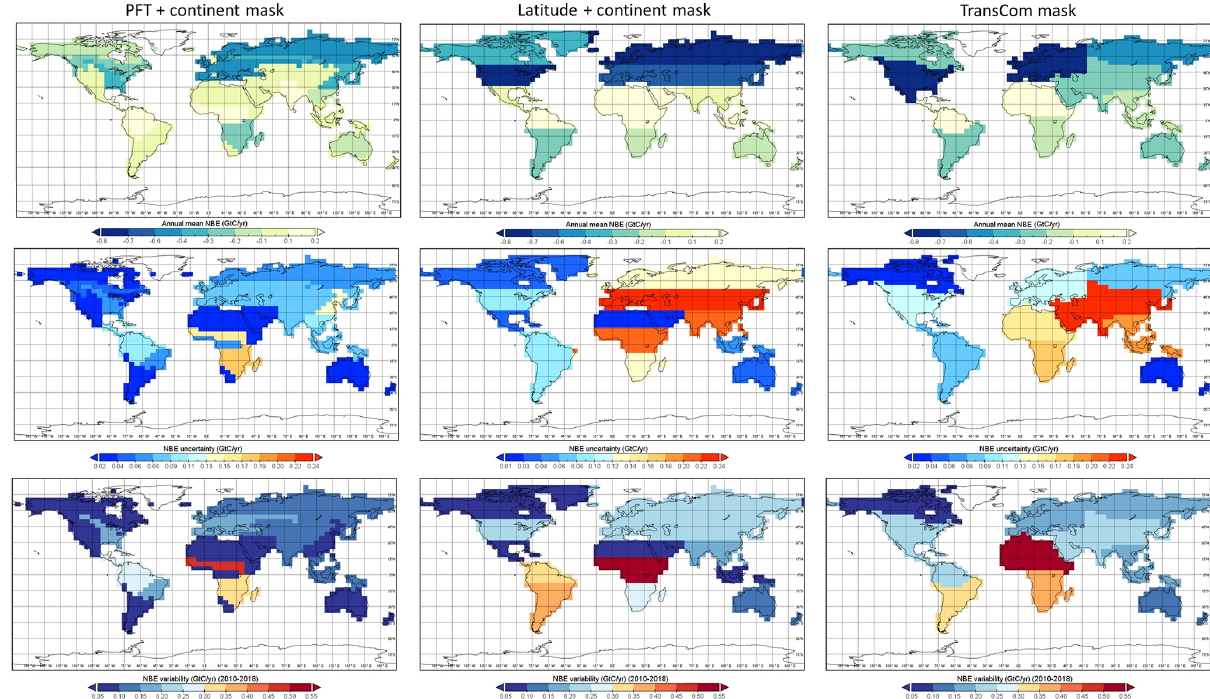
Figure 5. Mean annual regional NBE (a, b, c) , uncertainty (d, e, f) , and variability between 2010–2018 (g, h, i) with the three types of regional masks (Fig. 3). The first column uses a region mask based on plant functional types (PFTs) and continents (RM1). The second column uses a region mask based on latitude and continents (RM2), and the third column uses a TransCom mask.